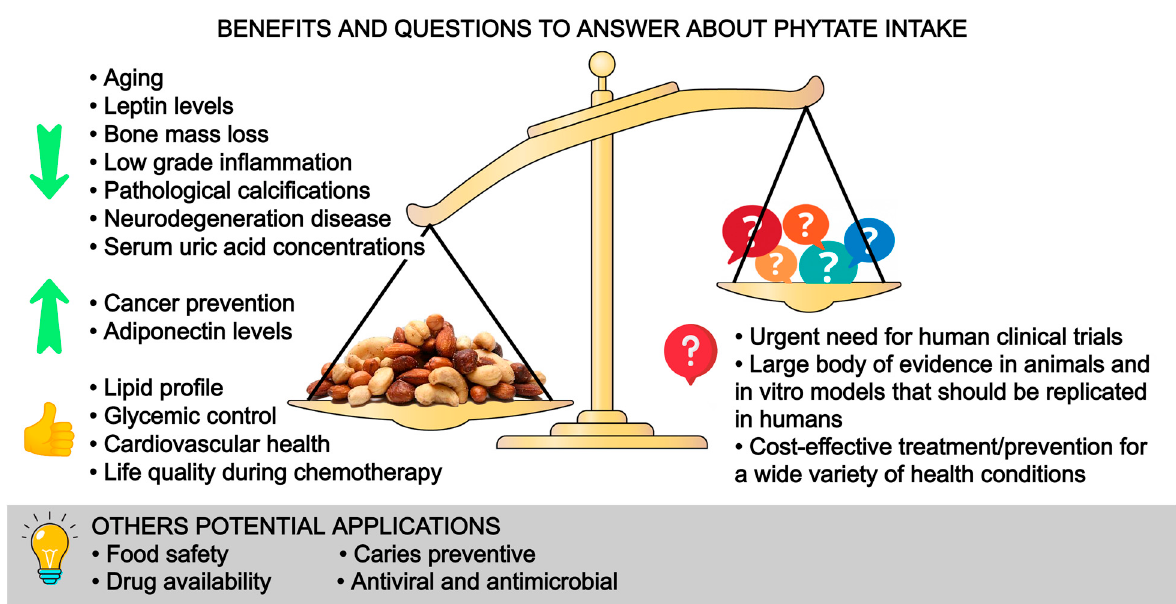
Figure 4. Benefits and questions to answer about phytate intake.